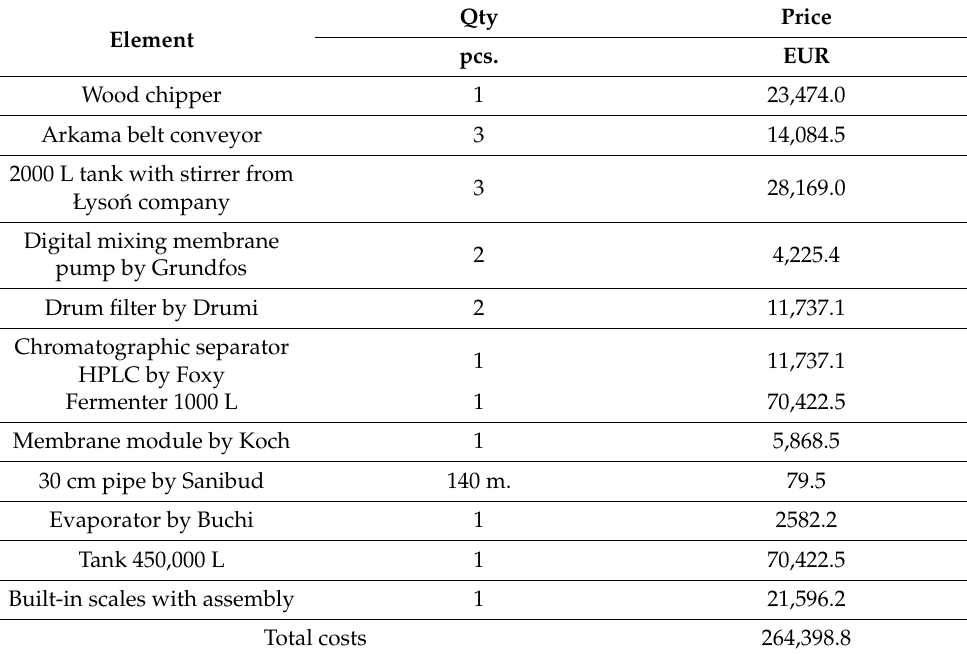
Table 6. Components of the production line necessary for second stage of bioethanol production. Qty Element